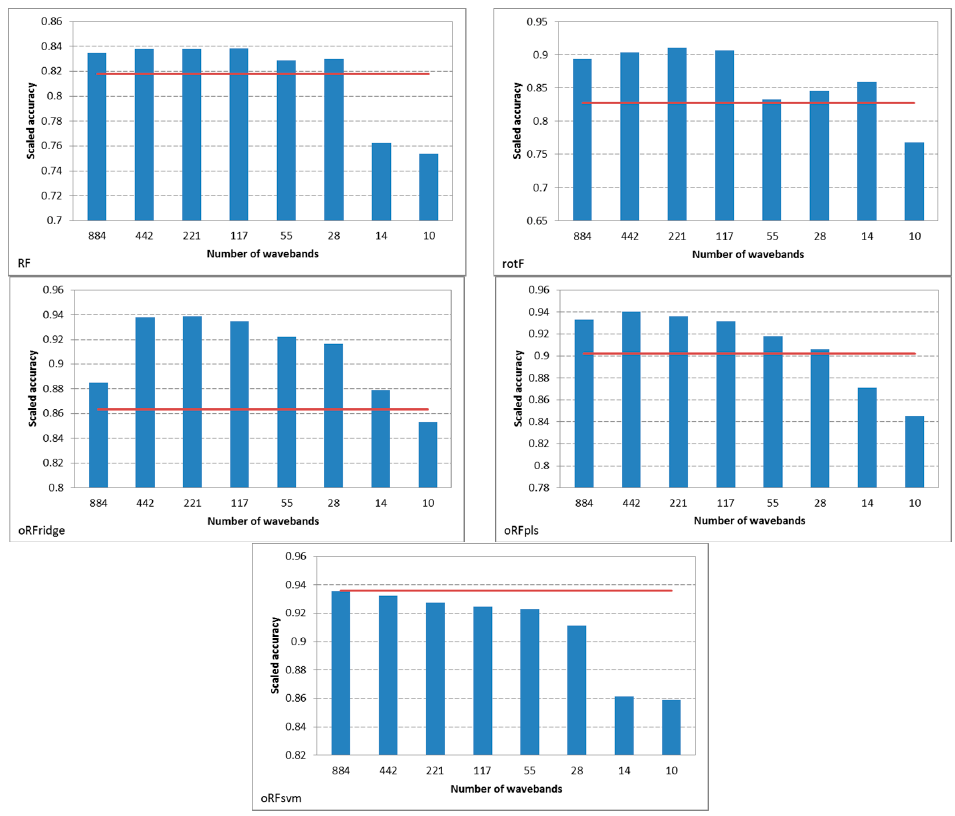
Figure 7. Comparison of the mean accuracies obtained using all bands and using the resampled bands for the five ensemble classifiers (RF = random forest; rotF = rotation forest; oRFridge = oblique random forest using ridge regression as splitting model; oRFpls = oblique random forest using PLS as splitting model; oRFsvm = oblique random forest using SVM as splitting model). The red line indicates the mean accuracy obtained using all the original bands ( n = 1769) whereas the blue bars indicate the mean accuracies for the respective resampled subsets.